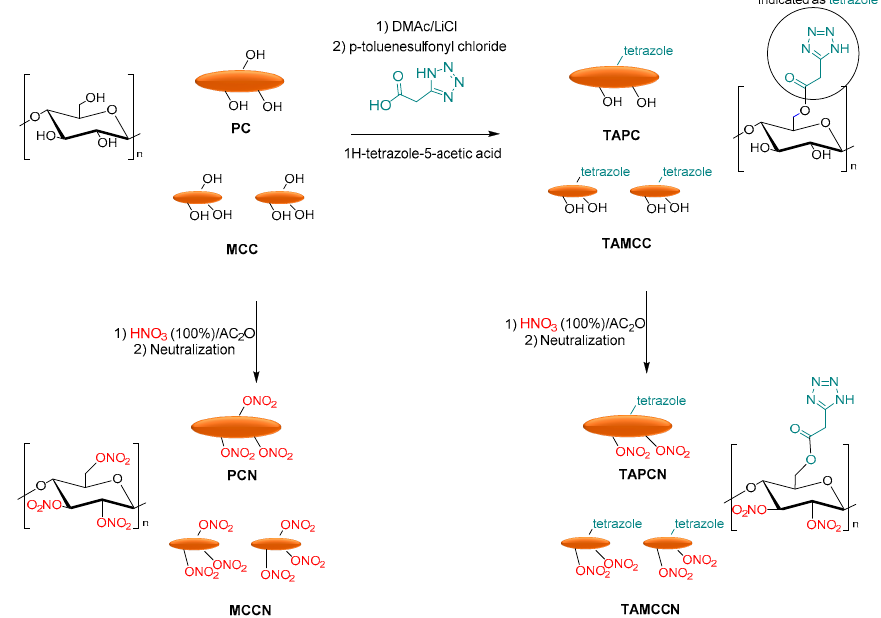
Figure 14. Synthesis of PCN, MCCN, TAPCN, and TAMCCN.